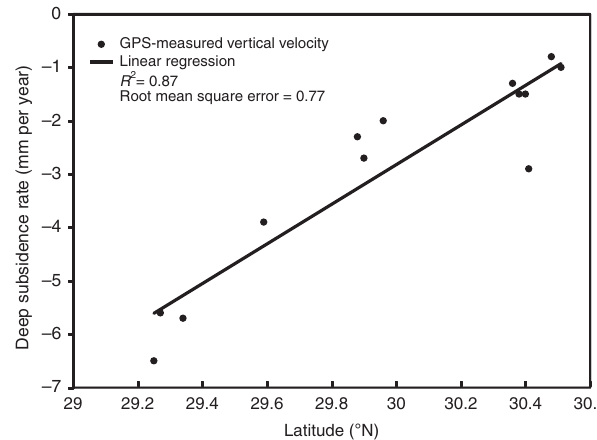
Figure 4 | DS rates in the Mississippi Delta. Linear regression of vertical velocity at 13 GPS stations 26 (see Supplementary Table 3) versus latitude within the Mississippi Delta. For each of the 185 Mississippi Delta sites, the DS rate was estimated by solving the linear model equation as a function of latitude.